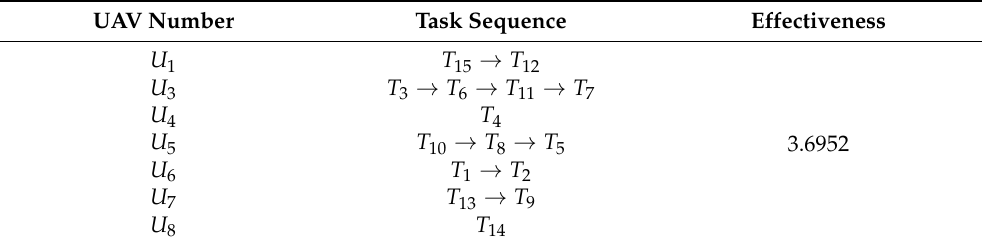
Table 13. Task allocation scheme new emergency